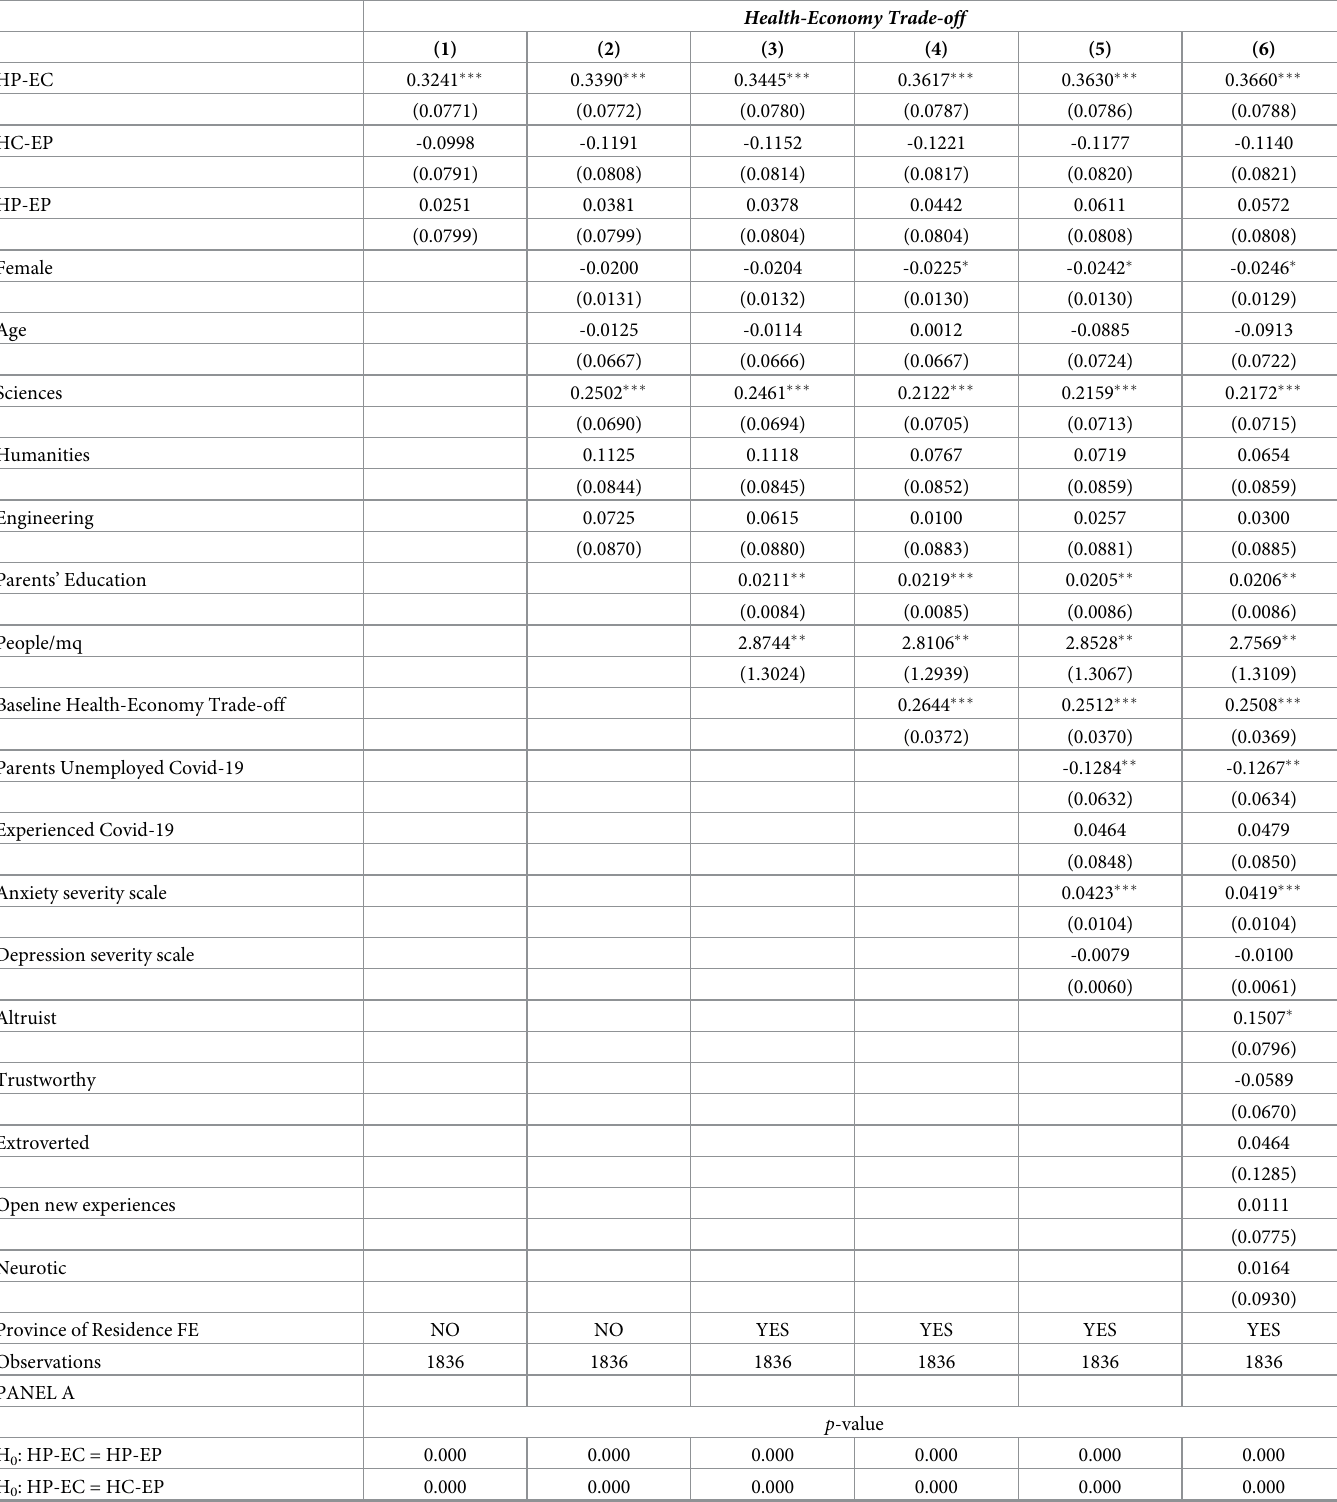
Table 3. The impact of communication on preferences for policies aimed at managing the Covid-19